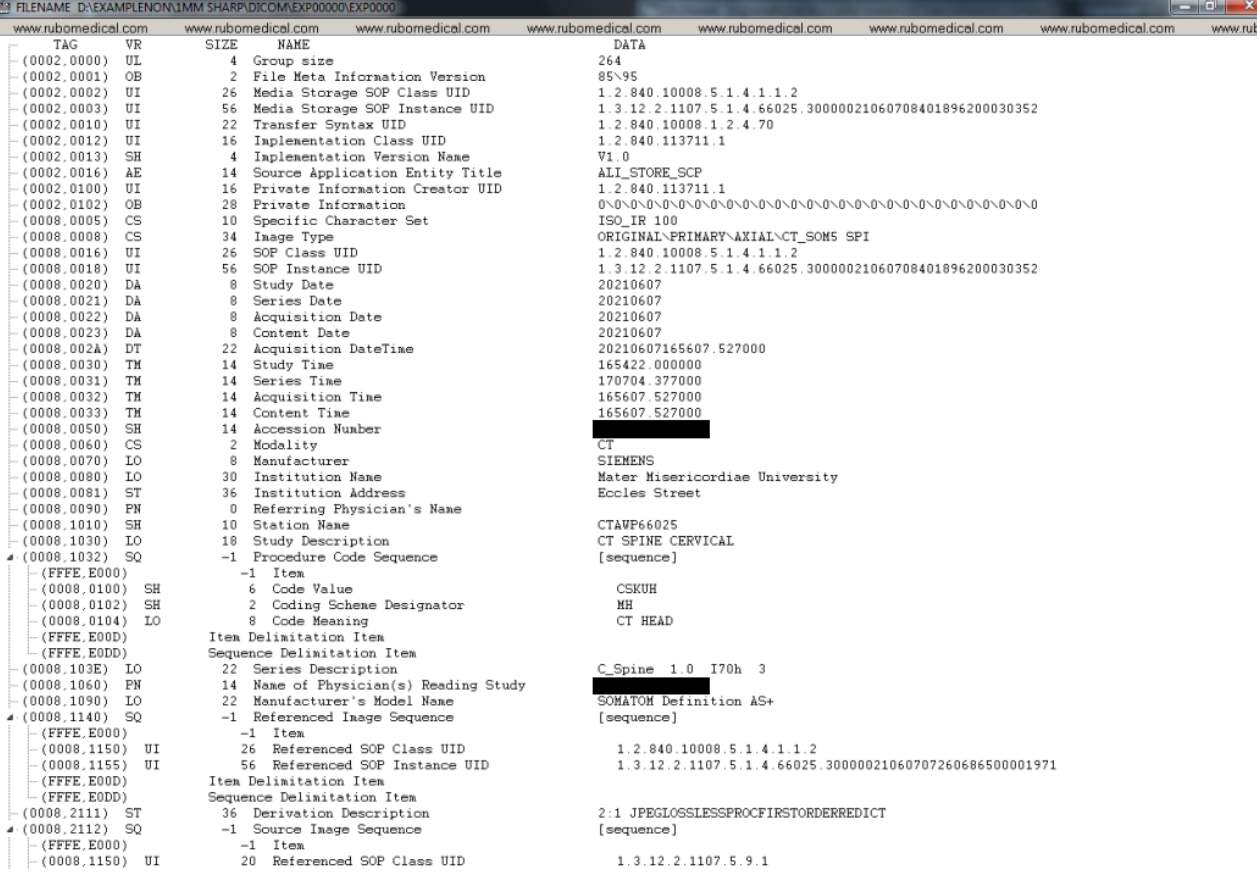
Figure A1. DICOM header data before de-identification (part